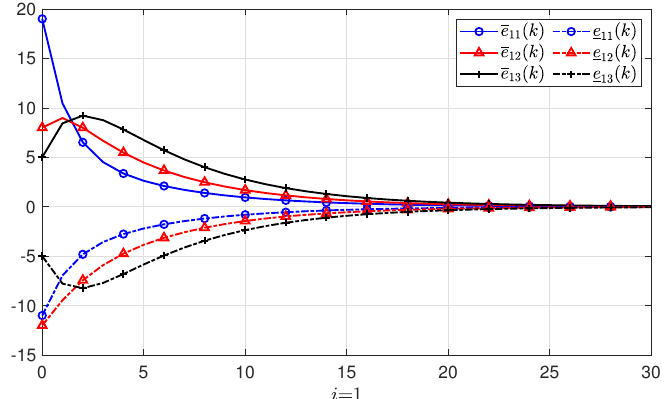
Figure 6. The simulations of state estimate errors e 1 ( k ) of the 1st agent.